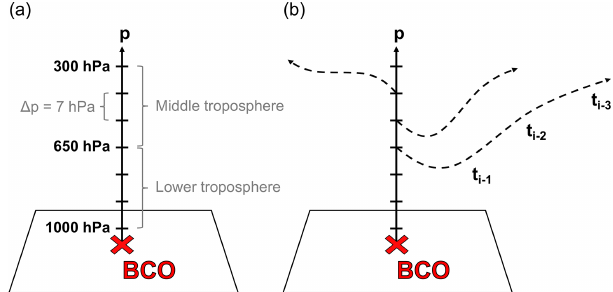
Figure 1. Illustrative schematics for (a) the definition of the ver- tical profiles above the BCO and (b) the calculation of the three- dimensional backward